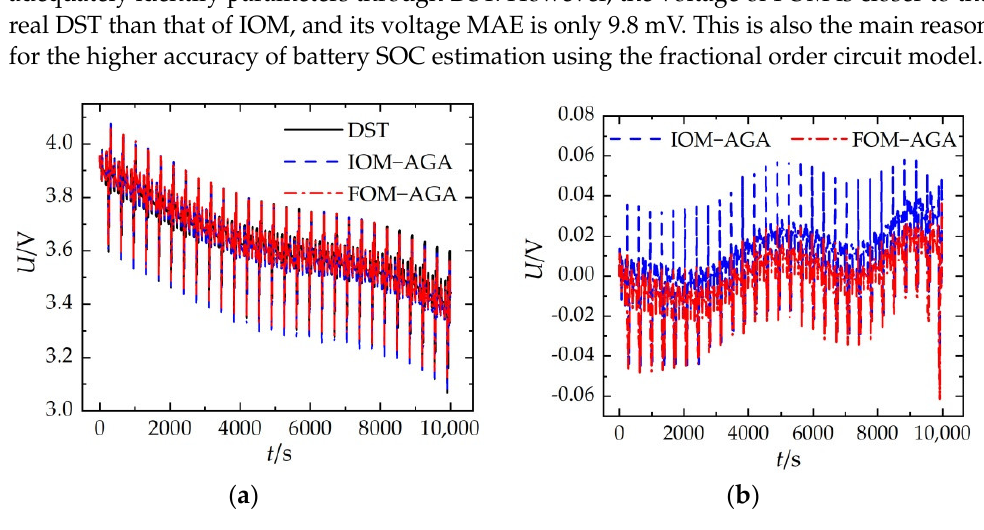
Figure 4. Predicted voltages and errors under DST: ( a ) predicted voltages; ( b ) voltage error.